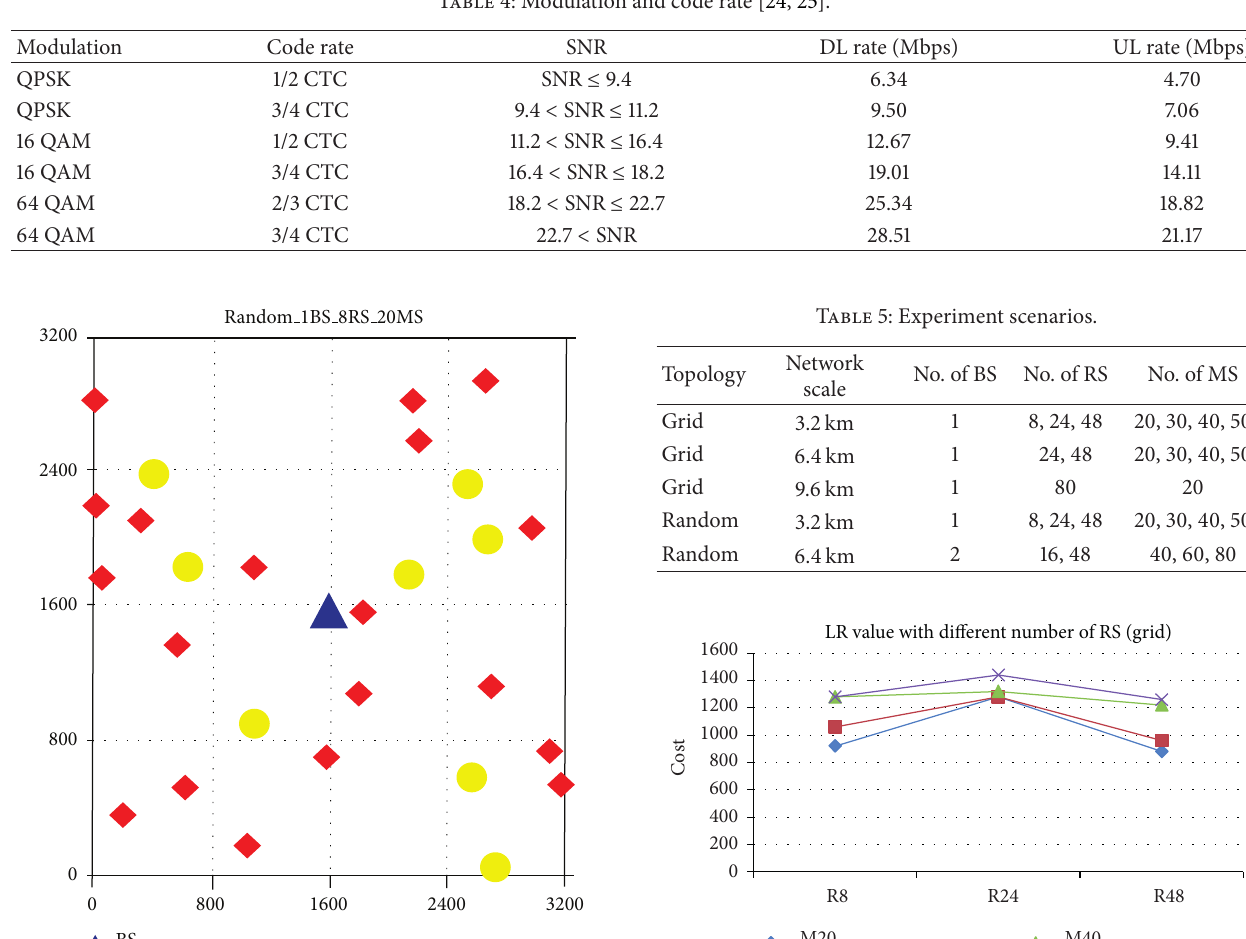
Table 4: Modulation and code rate [24, 25].